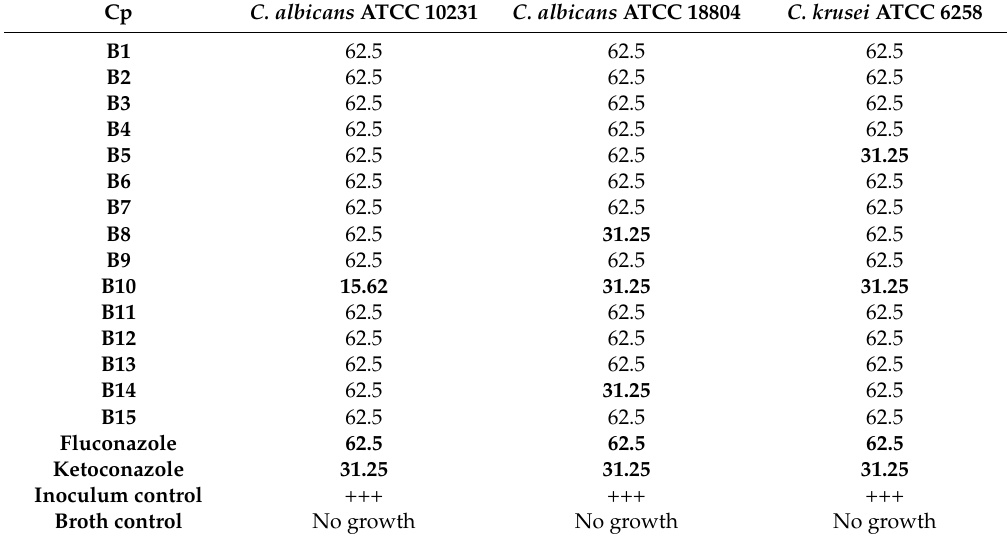
Table 2. Minimum Inhibitory Concentration—MIC (in µ g/mL) of compounds B1 – B15